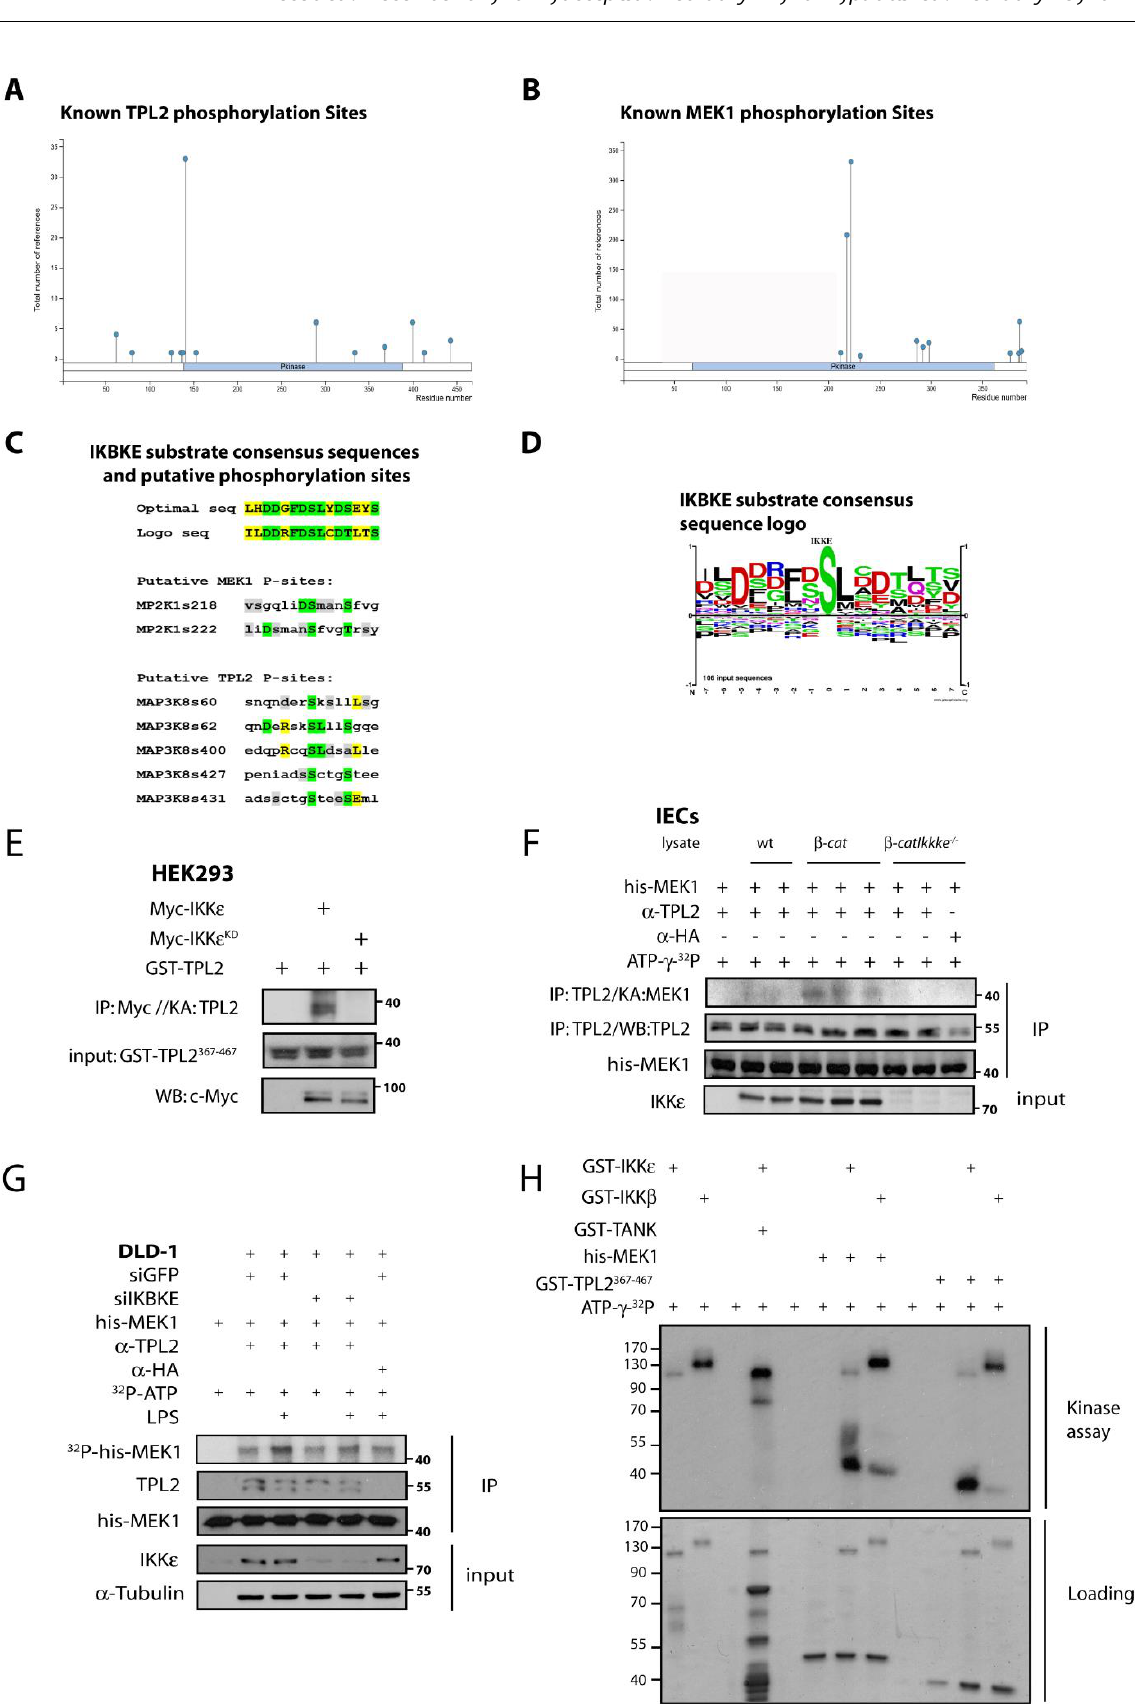
Figure 4: IKBKE phosphorylates TPL2 and MEK1 substrates in vitro and MEK1 phosphorylation by MAP3K8 depends on IKBKE. Known phospho-regulatory sites on (A) TPL2 and (B) MEK1.